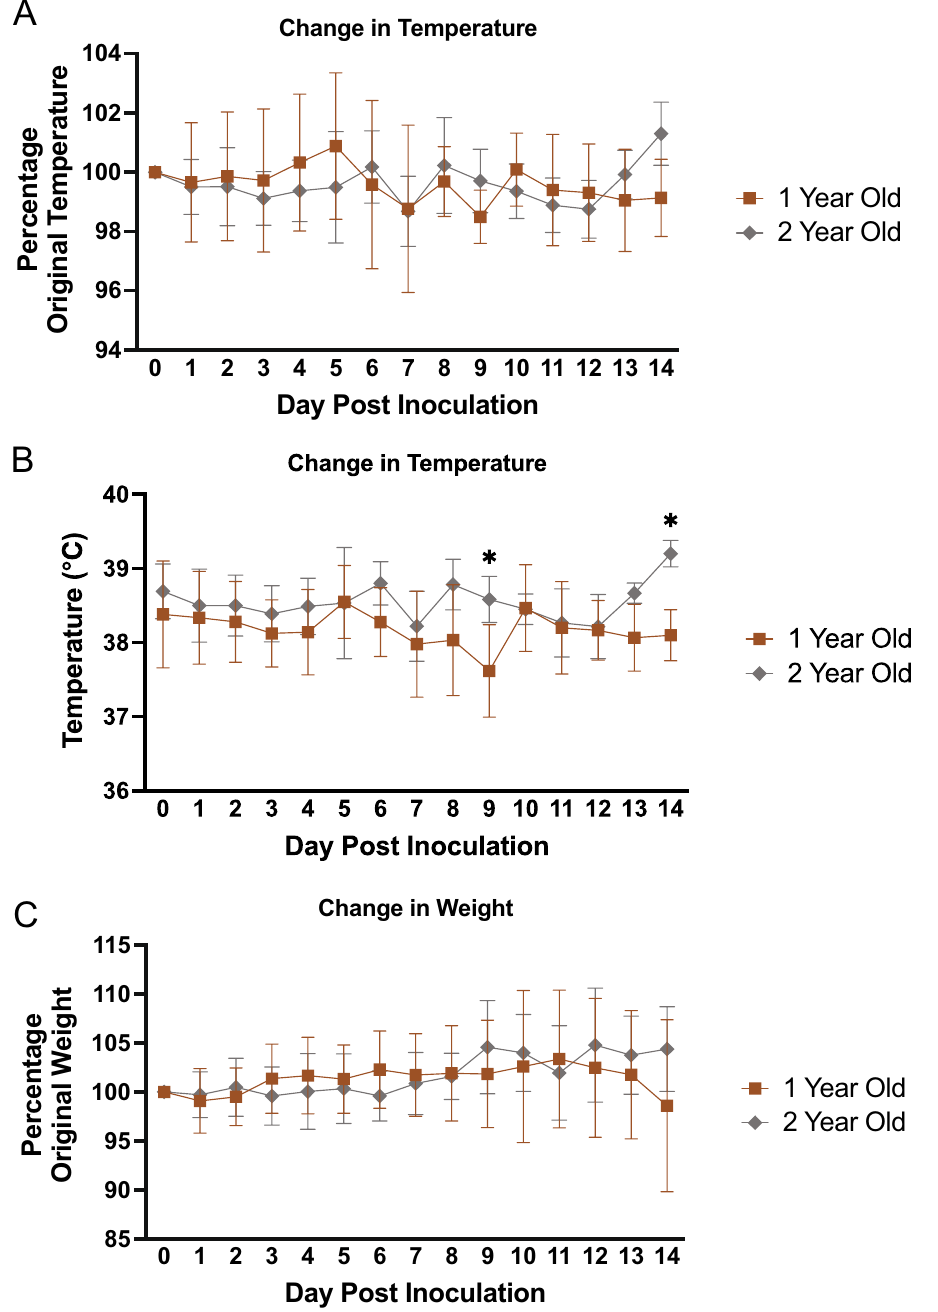
Figure 2. Intranasal SARS-CoV-2 infection in ferrets leads to significantly higher temperature in 2-year-old animals compared to 1-year-old animals. ( A ) 1-year-old and 2-year-old male ferrets were intranasally inoculated with SARS-CoV-2 (10 6 TCID 50 ) and temperature was also analysed for 14 days after inoculation and represented as a percentage of original temperature and ( B ) raw temperature. ( C ) Weight was recorded for 14 days post inoculation and represented as percentage of original weight. Results show the mean of at least 6 ferrets per group. *A p-value less than 0.05 determined by ANOVA comparing 1-year-old animals to 2-year-old animals. Error bars indicate ±